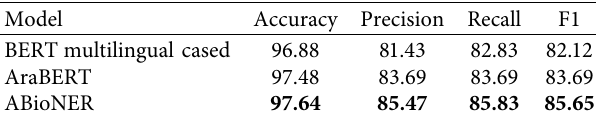
Table 3: Results for DS and TPP entities